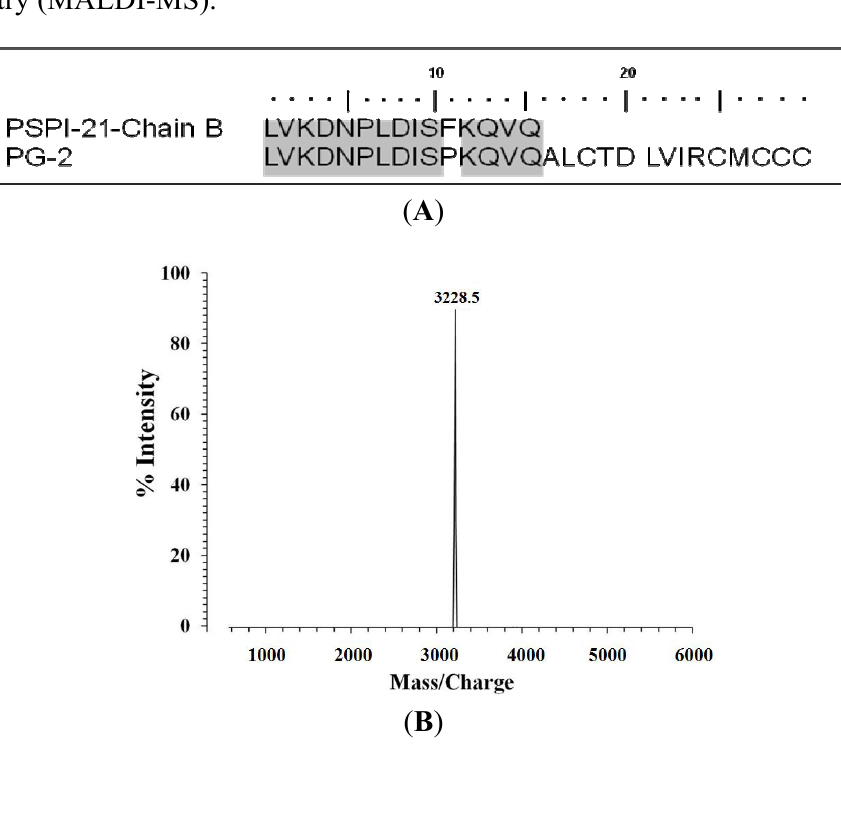
Figure 4. ( A ) Sequence of PG-2 isolated from potato tubers. The N -terminal 29